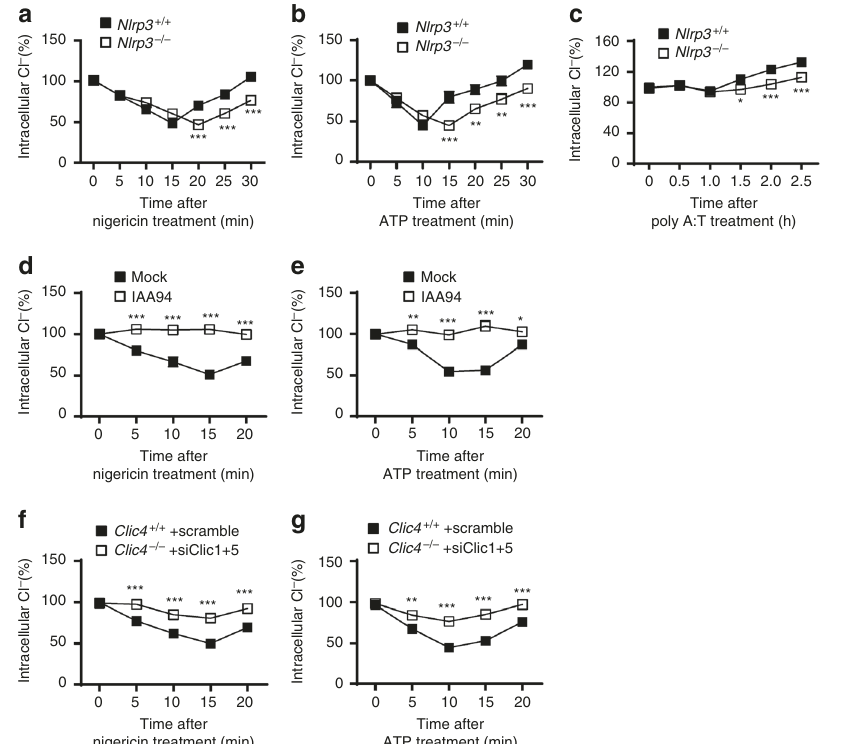
Fig. 4 Clics-dependent chloride ef fl ux during NLRP3 in fl ammasome activation. a – c Quali fi cation of the decrease of intracellular chloride in wild type or Nlrp3 – / – BMDMs at different time points after nigericin a , ATP b , or poly A:T c treatment. d , e Quali fi cation of the decrease of intracellular chloride in BMDMs at different time points after nigericin d or ATP e treatment with or without the pretreatment with IAA94 (150 μ M). f , g Quali fi cation of the decrease of intracellular chloride in Clic4 – / – BMDMs transfected siRNA against Clic1 and Clic5 at different time points after nigericin f or ATP g treatment. Data are from three independent experiments with biological duplicates in each (mean ± SEM of n = 6). Student ’ s t -test, * P < 0.05, ** P < 0.01, *** P <